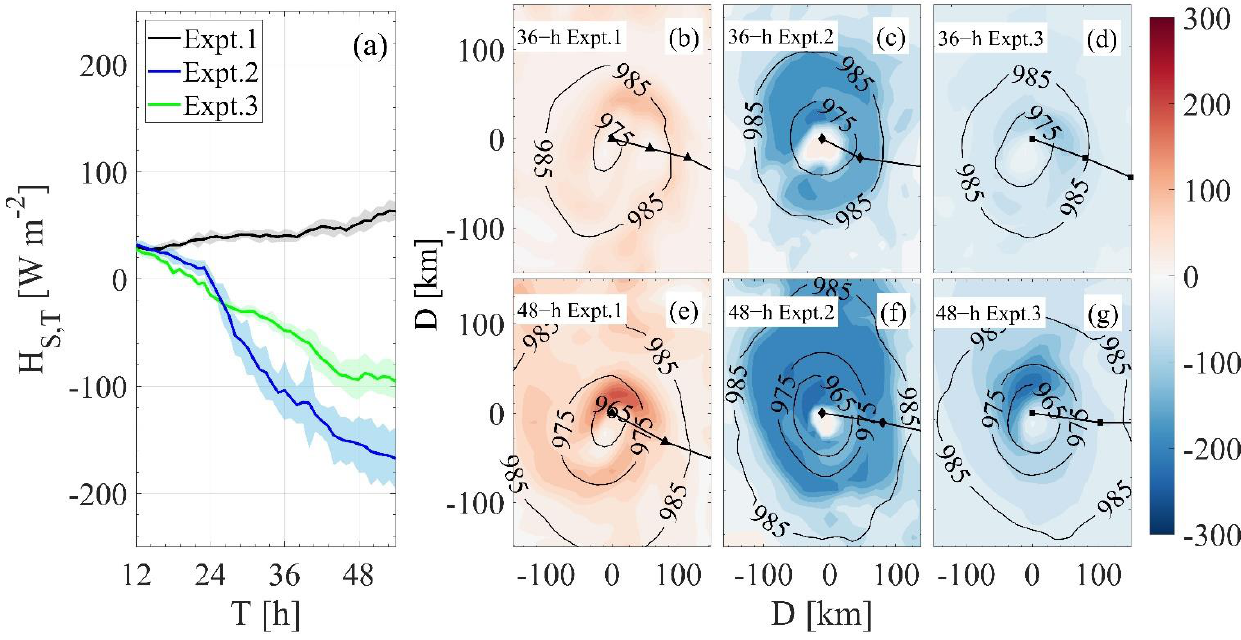
Figure 2. ( a ) The integrated air–sea sensible heat fluxes with the simulation time for the Expt.1, Expt.2, and Expt.3. Solid lines and shadows mark the mean and standard deviation of the area-averages within two times of the radius of maximum wind (RMW) from the center of TCs for the numerical experiments. ( b – d ) The spatial distributions of air–sea sensible heat fluxes (shadowing at the interval of 10 W m −2 ) and sea level pressure (SLP) (contouring at the interval of 10 hPa) with the 6 h TC tracks (black line with the triangle, diamond, and square markers) after 36 h simulation for Expt.1, Expt.2, and Expt.3, respectively. ( e – g ) The spatial distributions of air–sea sensible heat fluxes (shadowing at the interval of 10 W m −2 ) and sea level pressure (SLP) (contouring at the interval of 10 hPa) with the 6 h TC tracks (black line with the triangle, diamond, and square markers) after 48 h simulation for Expt.1, Expt.2, and Expt.3, respectively. Note, the tracks of TC are from the right to the left following the black line.